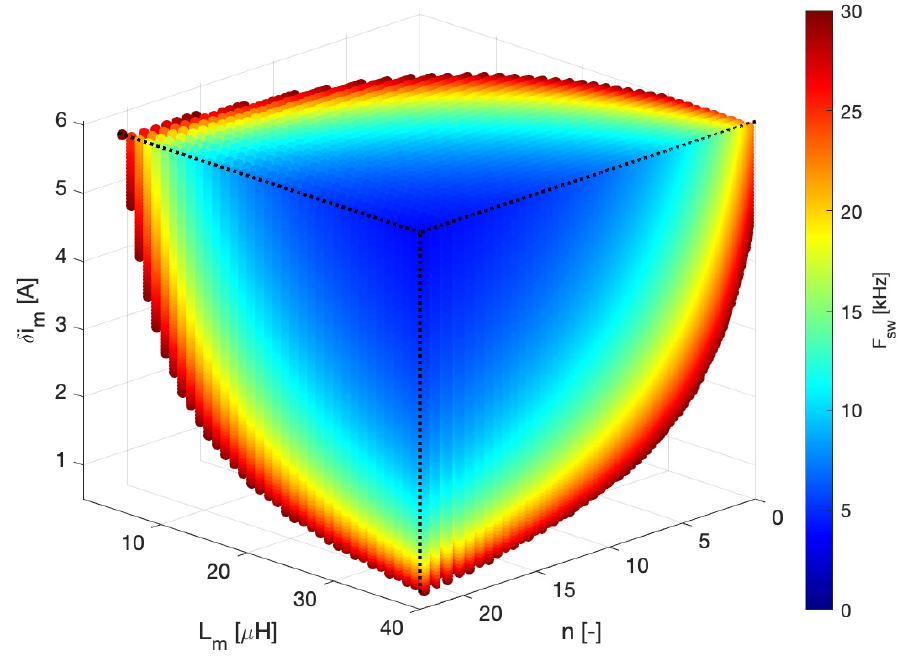
Figure 5. Effect of L m and n values on both δ i m and F sw . Table 2. Parameters of some commercial HFT designed for dc/dc